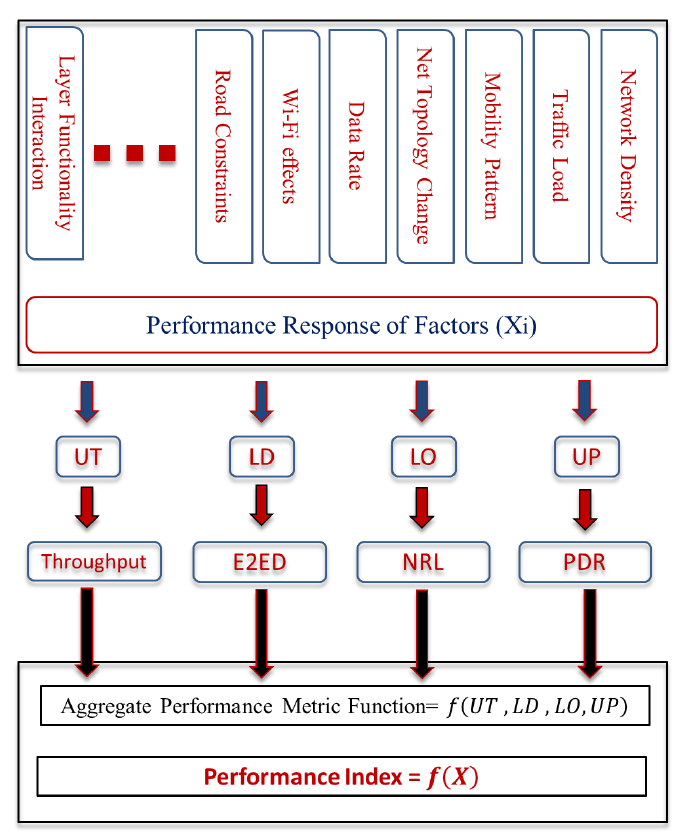
Figure 1. Statistical Function of